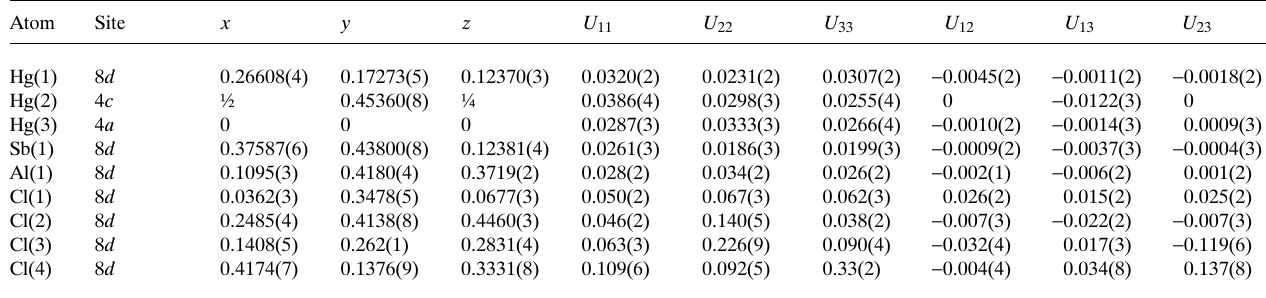
Table 2. Atomic coordinates and displacement parameters (in Å 2 ) .